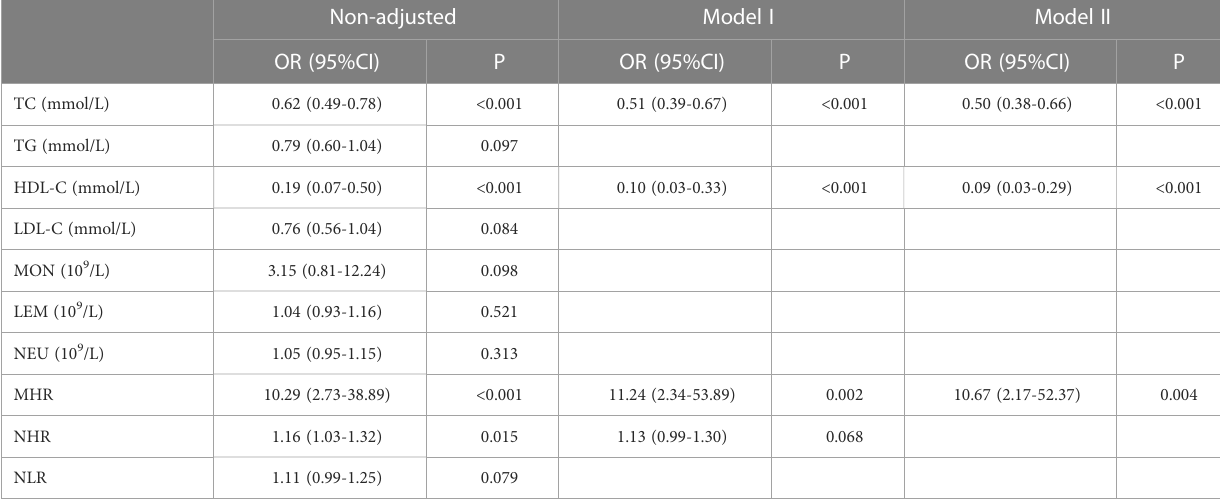
TABLE 3 Univariate and multivariate analyses of factors associated with